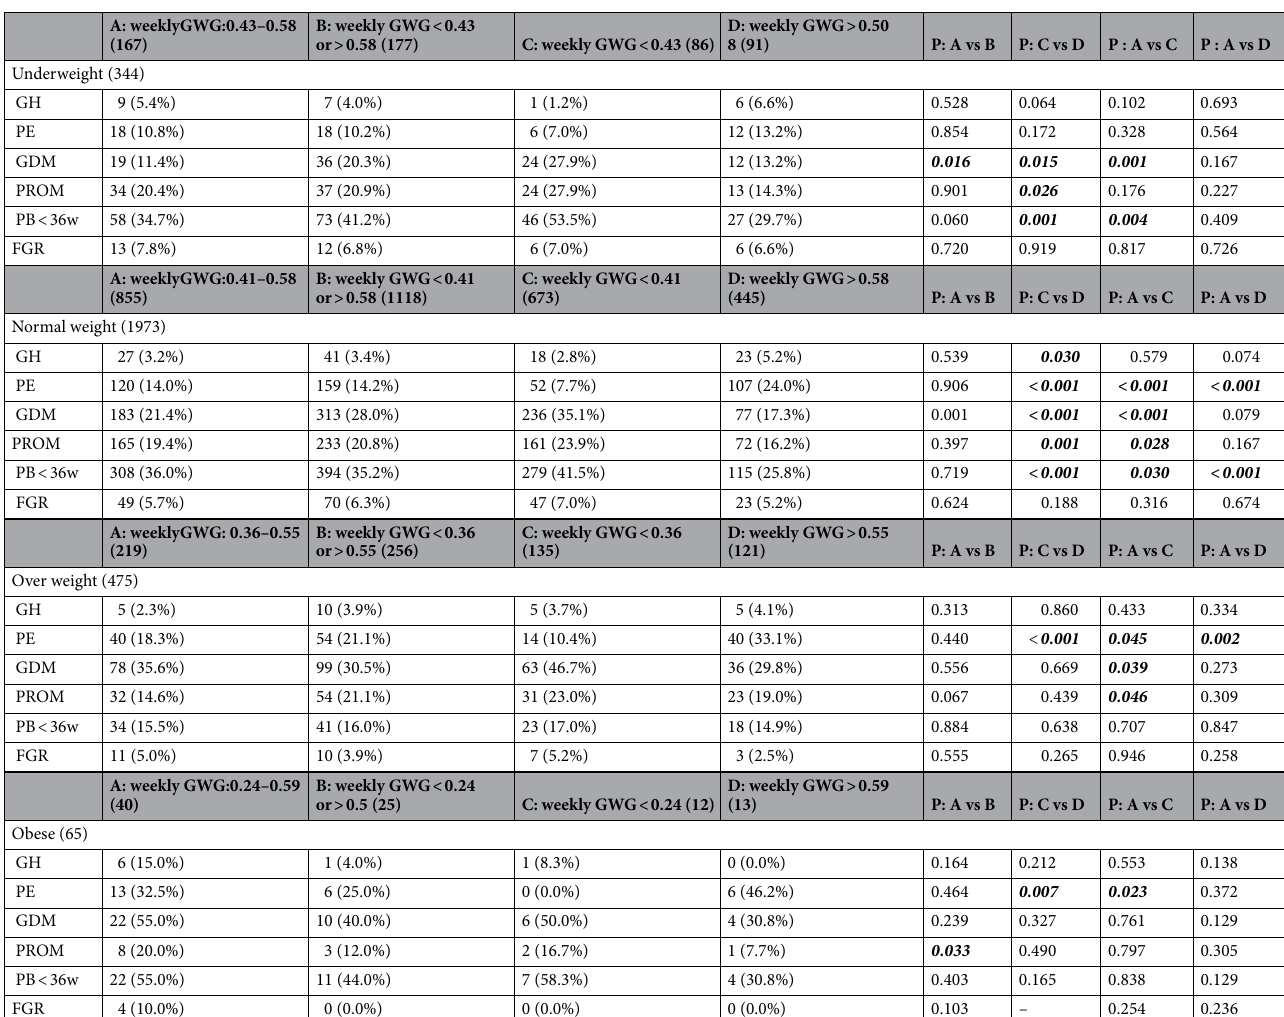
hypertension, PE preeclampsia, GDM gestational diabetes mellitus, PROM premature rupture of membranes, PB preterm birth, FGR fetal growth restriction. A represents the women in the optimal GWG range.